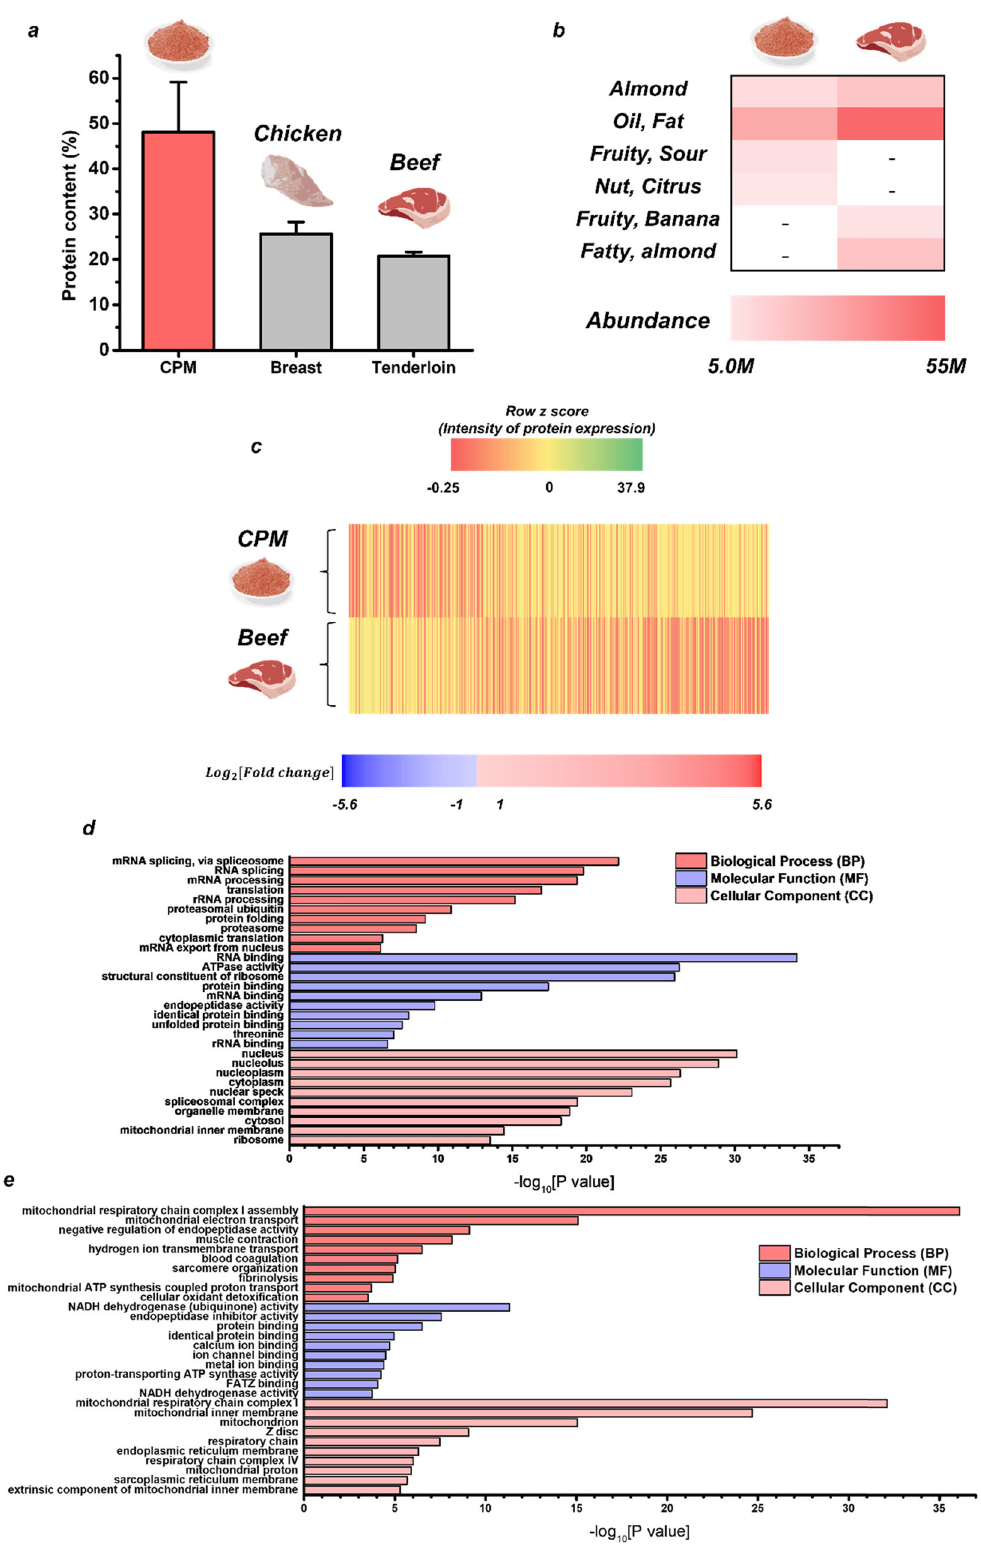
Fig. 2 Protein content, fl avor, and protein expression of the CPM and beef tissue. a a comparison of the protein contents (%) of the CPM (Cell powder meat; G2), chicken breast, and beef tenderloin, and b a heat map comparing the fl avor intensity of the CPM with that of beef tenderloin. The comparative proteomic analysis of the CPM and bovine muscle tissue: c heat maps showing the clustering of differentially expressed proteins in terms of intensity; d , e gene ontology maps of d , the signi fi cantly upregulated proteins and e the signi fi cantly downregulated proteins in the CPM relative to the beef